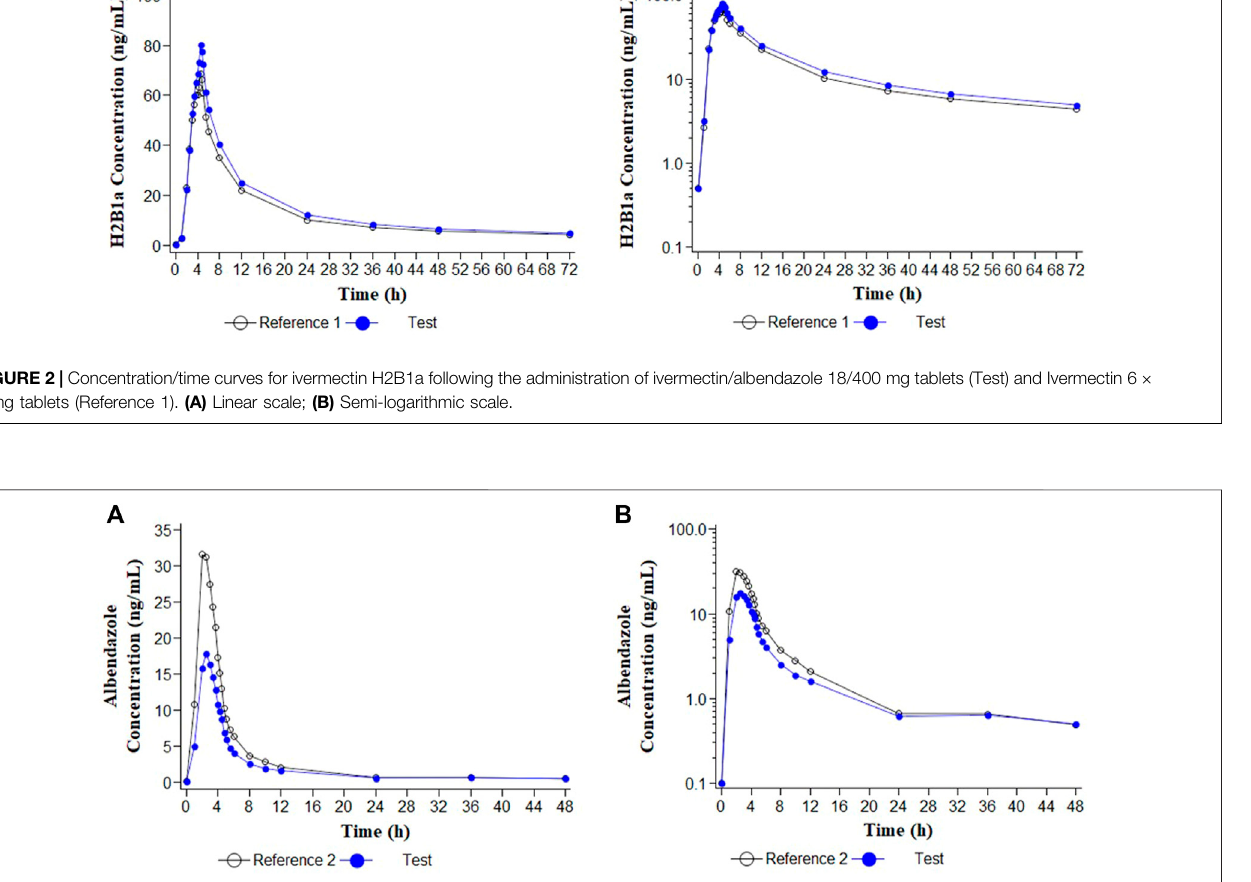
FIGURE 3 | Concentration/time curves for albendazole following the administration of ivermectin/albendazole 18/400 mg tablets (Test) and albendazole tablets (Reference 2). (A) Linear scale; (B) Semi-logarithmic scale.